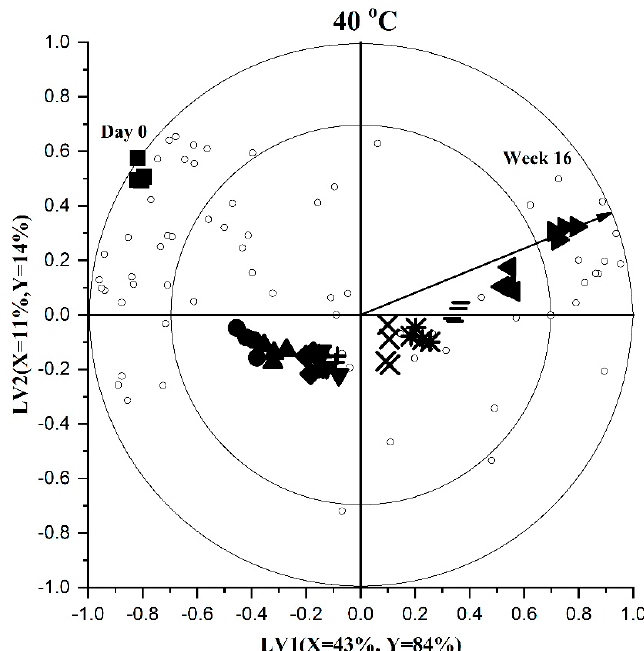
Figure 2. Partial least squares regression (PLSR) bi-plots visualising volatile changes in the headspace fraction of pasteurized apple juice during storage at 20, 30 and 40 ° C. Up to 11 sampling points were used during storage at each storage temperatures (details are attached in the supplementary): time 1 ( ■ ); time 2 ( ● ); time 3 ( ▲ ); time 4 ( ▼ ); time 5 ( ♦ ); time 6 ( + ); time 7 (X); time 8 ( * ); time 9 (-); time 10 ( ◀ ); time 11 ( ► ). The X and Y -variances represented by latent variables (LV)1 and LV2 are shown.